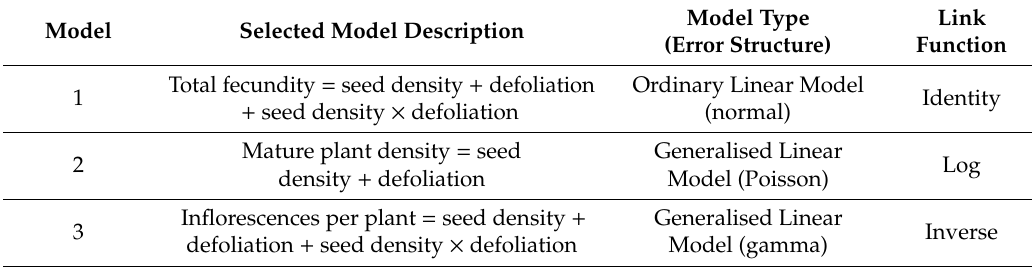
Table 5. The resulting optimal models, their error structures, and link functions used in the statistical analysis of seed density and defoliation on mature barley grass plant density and seed production under greenhouse conditions at Wagga Wagga,